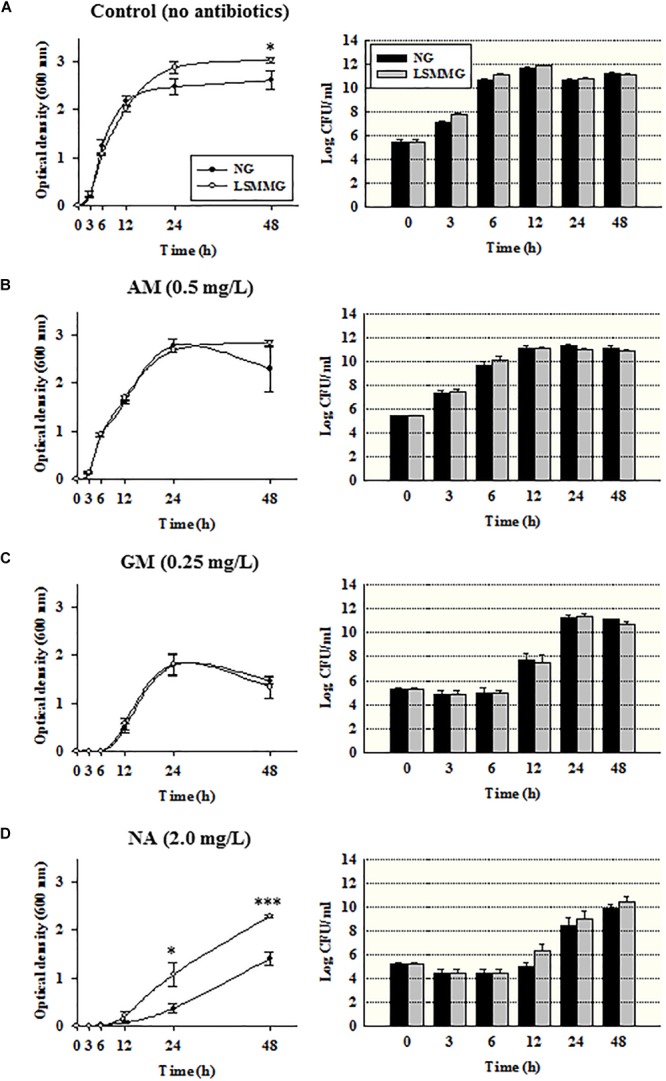
Optical density at 600 nm and viable cell counts of Escherichia coli O157:H7 cultured under NG and LSMMG in (A) MH broth with no antibiotics, or with the sub-inhibitory antibiotic concentrations (1/2 × MIC); (B) 0.50 mg/L of AM; (C) 0.25 mg/L of GM; and (D) 2.0 mg/L of NA. The data are presented as the mean ± standard error (SE) from 6 to 10 independent experiments. The asterisks represent significant differences between NG and LSMMG cultures (∗P < 0.05, ∗∗P < 0.01, and ∗∗∗P < 0.001).